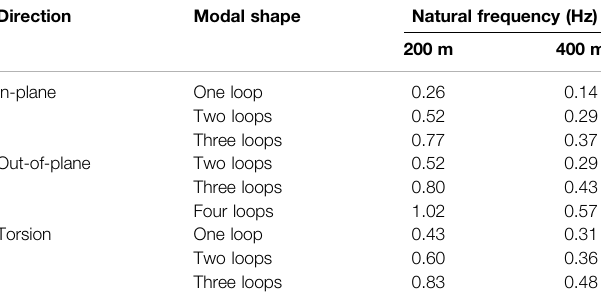
TABLE 4 | Modes and natural frequencies of the iced eight-bundle conductor.